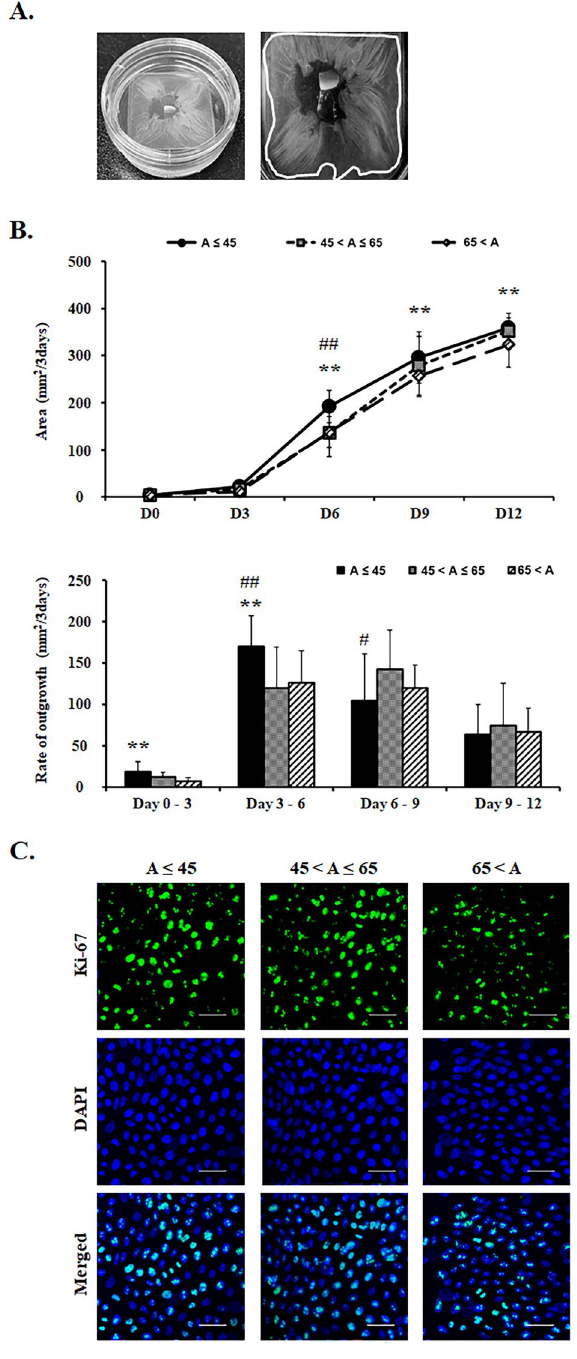
Figure 1. The growth and proliferation of limbal explant outgrowth populations from different donor’s ages. ( A ) Limbal explant outgrowth sheet on human amniotic membrane scaffold. ( B ) Area of limbal explant outgrowth sheets and rate of outgrowth (mm 2 /3 days) by day 12. ( C ) Representative images of explant outgrowths stained for Ki67. Bar = 20 μm. **p < 0.01 (vs. 65 < A), # p < 0.05 (vs. 45 < A ≤ 65), ## p < 0.01 (vs. 45 < A ≤ 65), n = 6 from 3